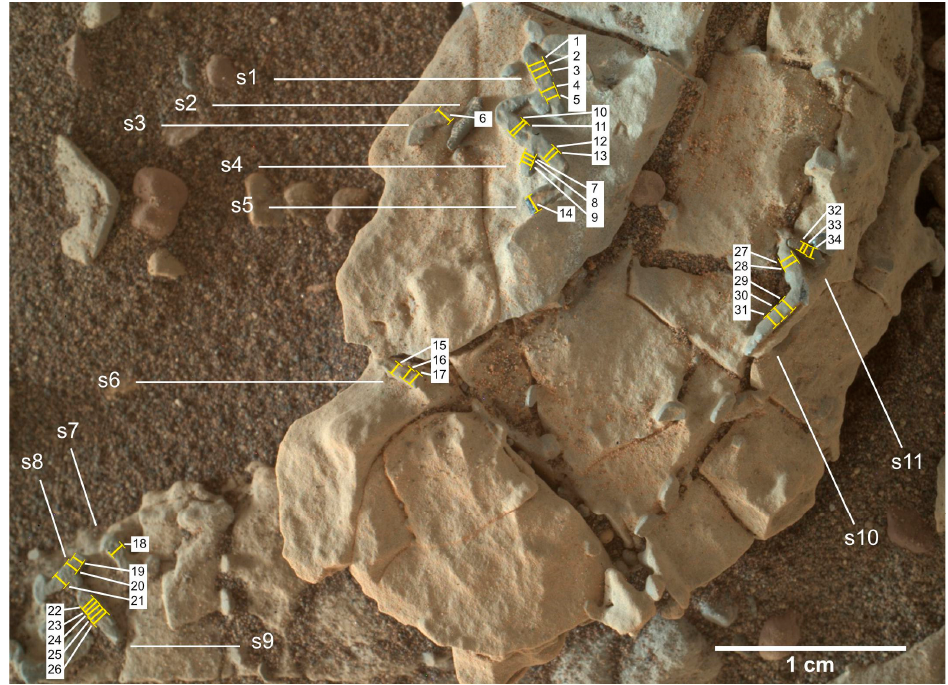
Figure A1. Width analysis map. Numbers 1–34 refer to the measurement ID in Table A1. Geosciences 2020 , 10 , 39